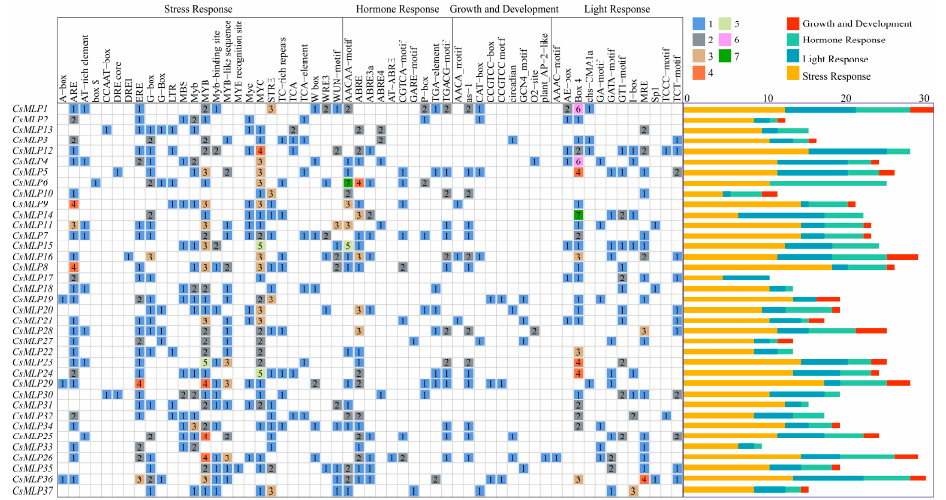
Figure 4. Predicted regulatory elements in the promoter regions of CsMLP genes. Promoter se- quences (–2000 bp) for 37 CsMLP genes are analyzed. The names of the promoters of CsMLP genes are shown at the top of the figure. Arabic numerals 1~7 in a square box indicate the number of specific cis -elements. The total number of cis -elements from different functional categories is marked with a different color.